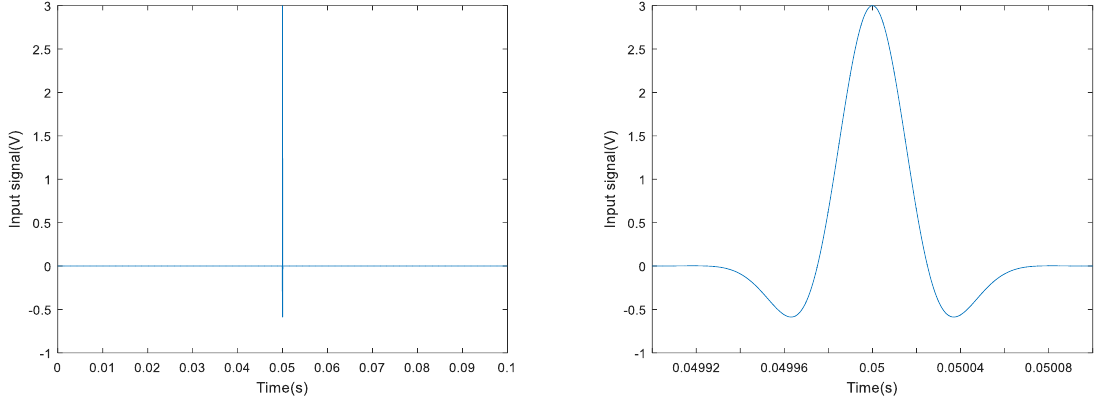
Figure 11. The Gaussian pulse signal.